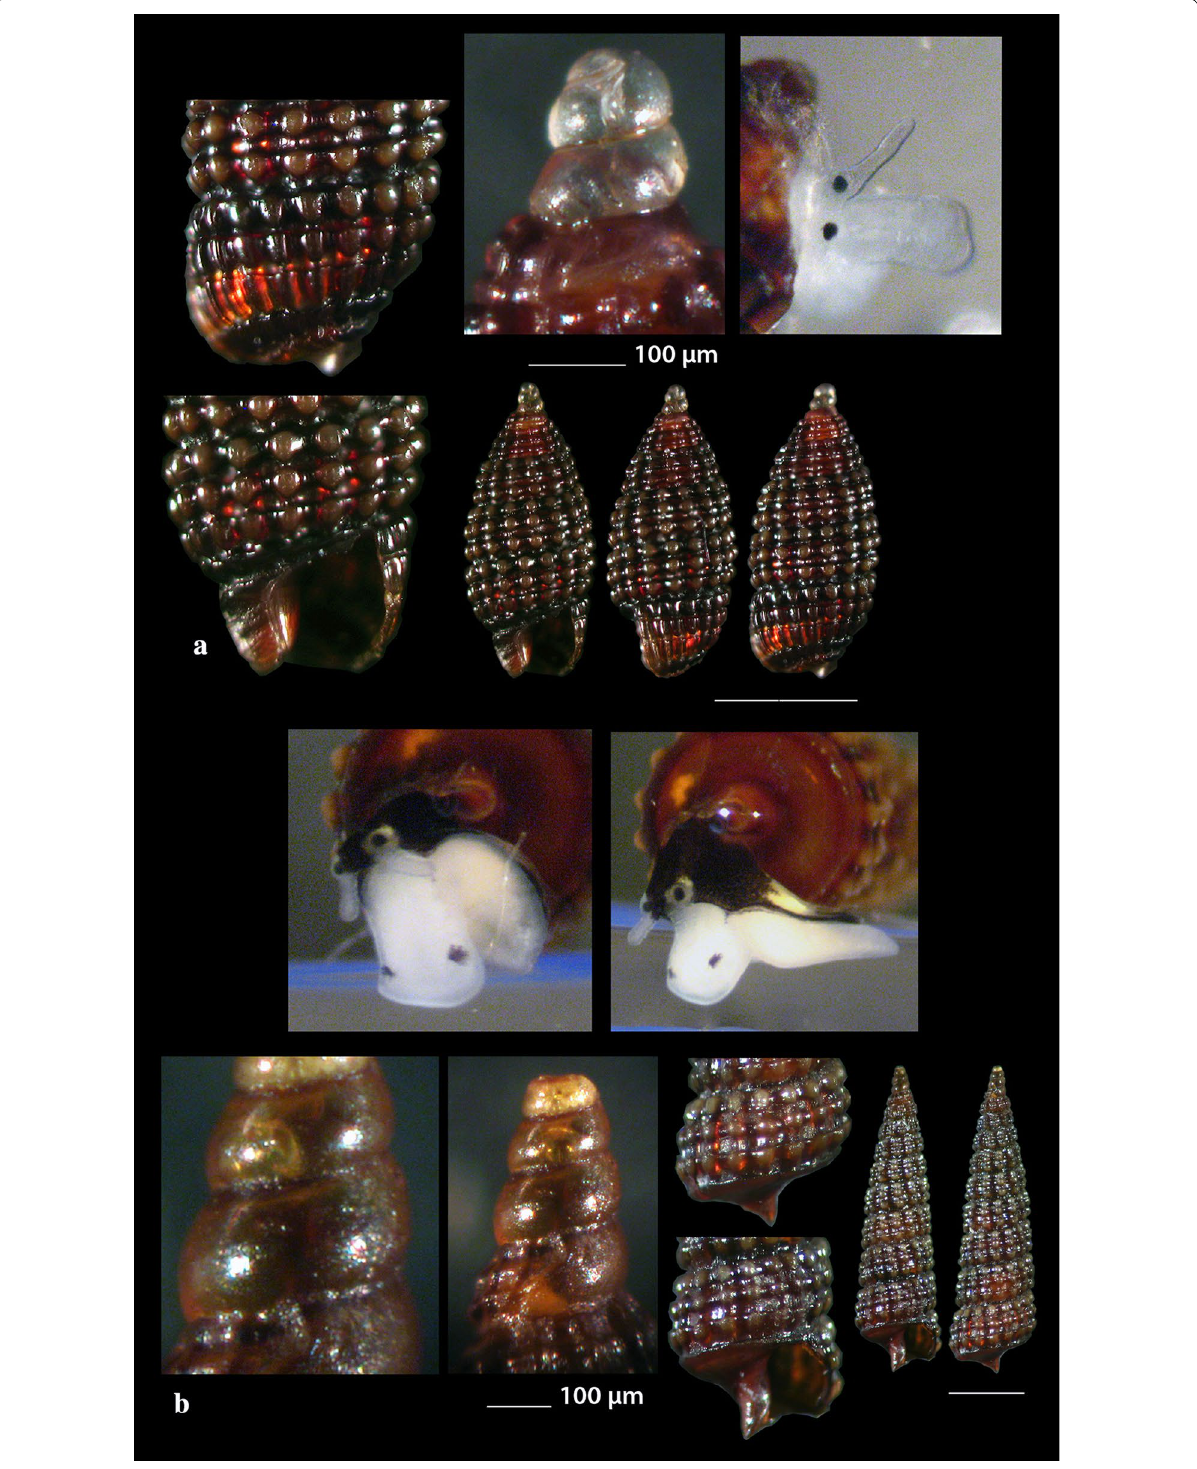
Fig. 12 a Cerithiopsis ladae , b Cerithiopsis oculisfictis . Bar